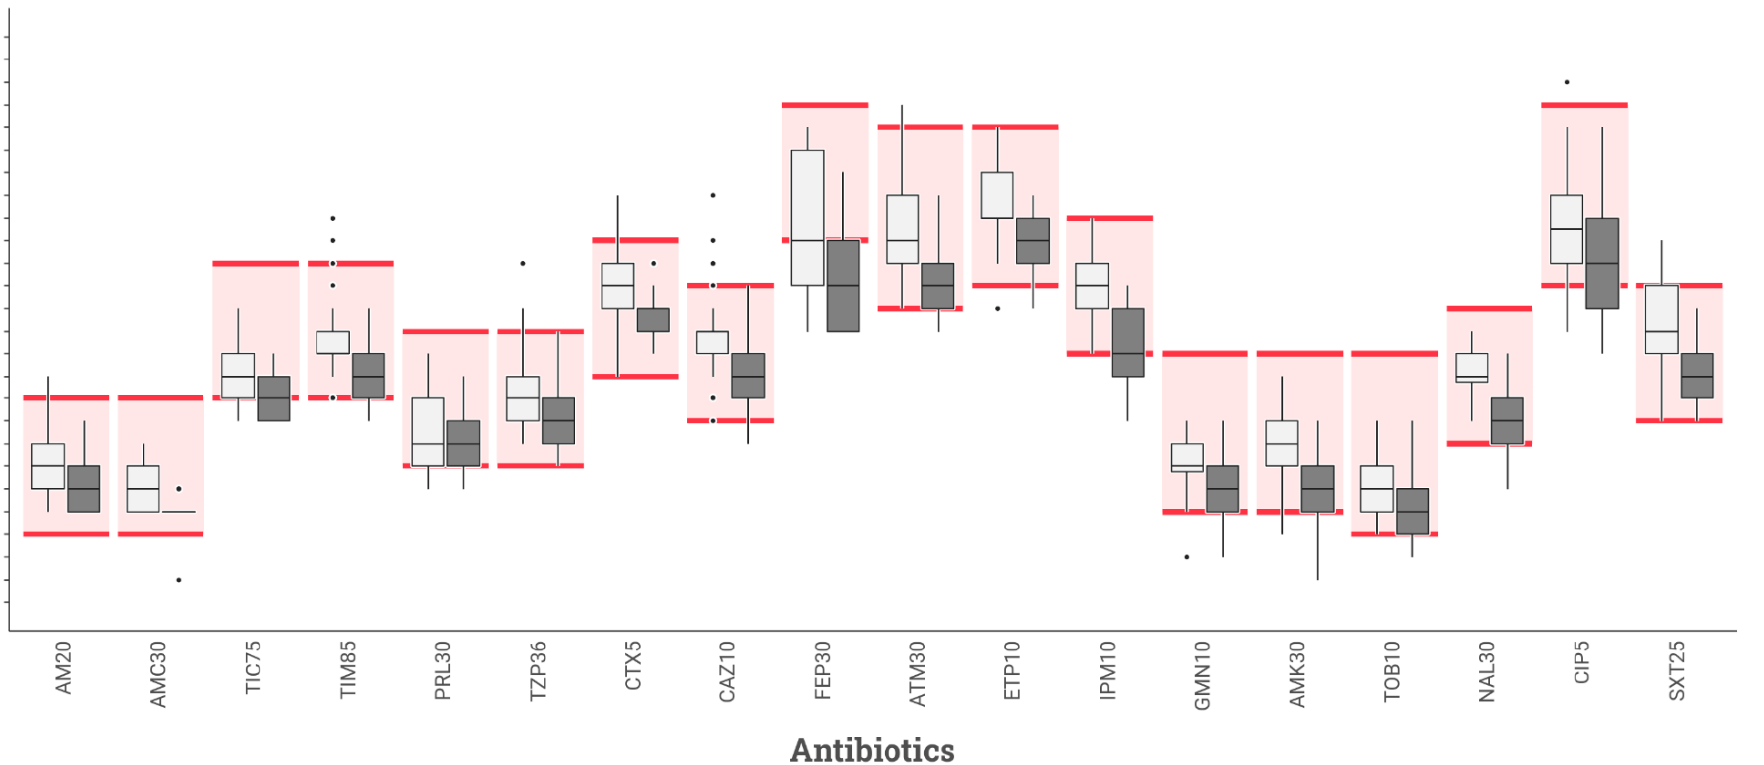
Figure 3. Inhibition diameters for various antibiotics tested on MHR-SIR agar of E. coli strain ATCC 25922 obtained during reproducibility study comparing 2 inoculation protocols: BSAC (white box-plot) vs. CASFM-EUCAST (black box-plot) recommendations. The boxplot shows the 25th and 75th percentile with a horizontal bar indicating the median. Whiskers represent the 5th and 95th percentile. Extreme values are shown with dots. The colored rectangle indicates the acceptable limit values for each antibiotic according to the CASFM 2019 v2 recommendations. AM20 = Amoxicillin 20 µg, AMC30 = Amoxicillin-clavulanic acid 30 µg, TIC75 = Ticarcillin 75 µg, TIM85 = Ticarcillin-clavulanic acid 85 µg, PRL30 = Piperacillin 30 µg, TPZ36 = Piperacillin-tazobactam 36 µg, CTX5 = Cefotaxime 5 µg, CAZ10 = Ceftazidime 10 µg, FEP30 = Cefepime 30 µg, ATM30 = Aztreonam 30 µg, ETP10 = Ertapenem 10 µg, IPM10 = Imipenem 10 µg, GN10 = Gentamicin 10 µg, AK30 = Amikacin 30 µg, TOB10 = Tobramycin 10 µg, NA30 = Nalidixic acid 30 µg, CIP5 = Ciprofloxacin 5 µg, SXT25 = Trimethoprim + sulfamethoxazole 25 µg.